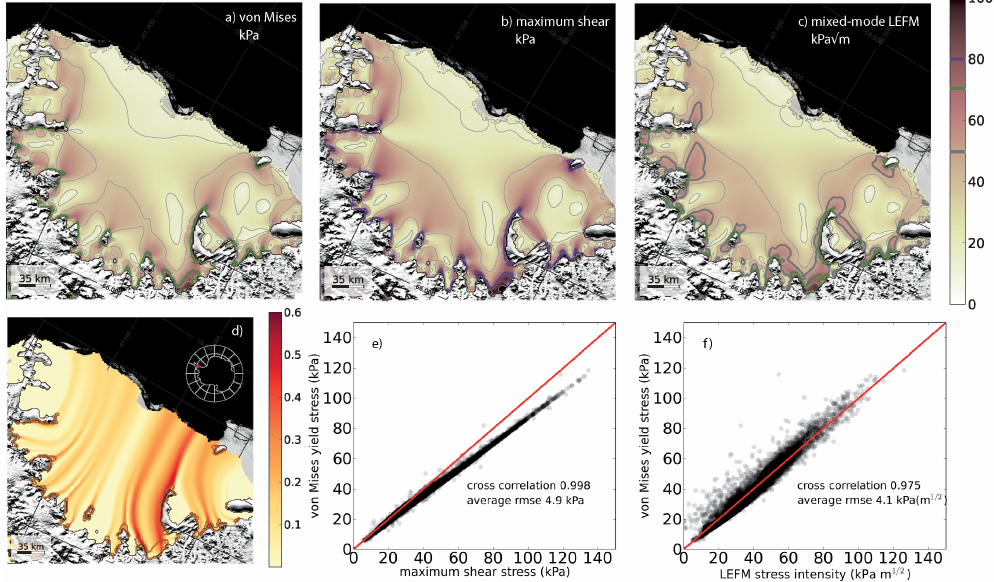
Fig. 2. Comparison of von-Mises effective stress (a) , maximum-shear stress (b) and LEFM-stress intensity (c) in the Larsen C ice shelf √ √ region with thin grey contours every 20kPa( m), green contour at 70kPa( m) and violet at 80kPa. Resultant steady-state fracture density is shown in the lower left panel, no healing or softening applied. Scatter plots in the lower right panels show the point-wise comparison for the given